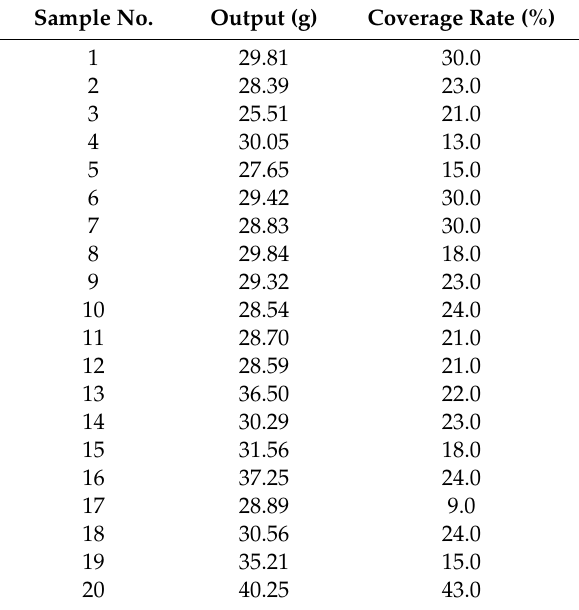
Figure 3. Optical micrograph (OM) of microcapsules: ( A – P ) correspond to Samples 1–16 in the orthogonal test of Table 2. Table 3. Output and coverage rate of